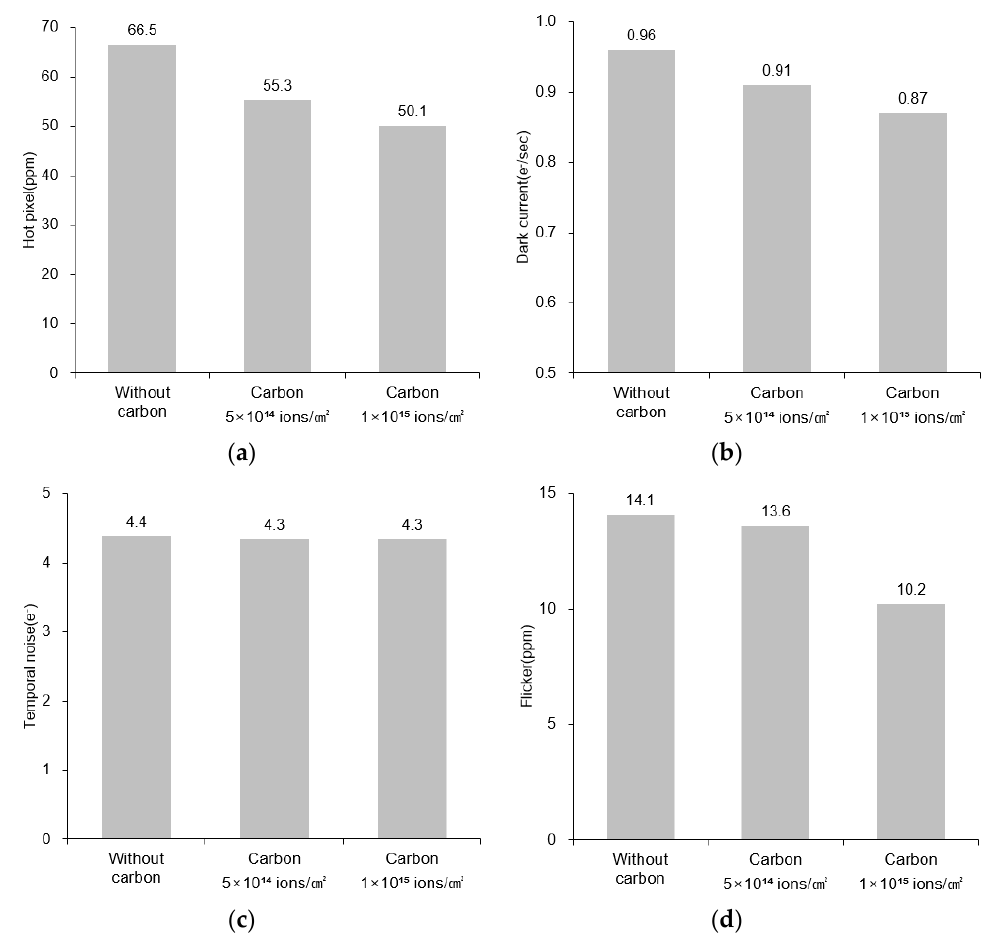
Figure 8. Measurement results of dark current characteristics. ( a ) hot pixel, ( b ) dark current, ( c ) tem- poral noise, ( d ) flicker.